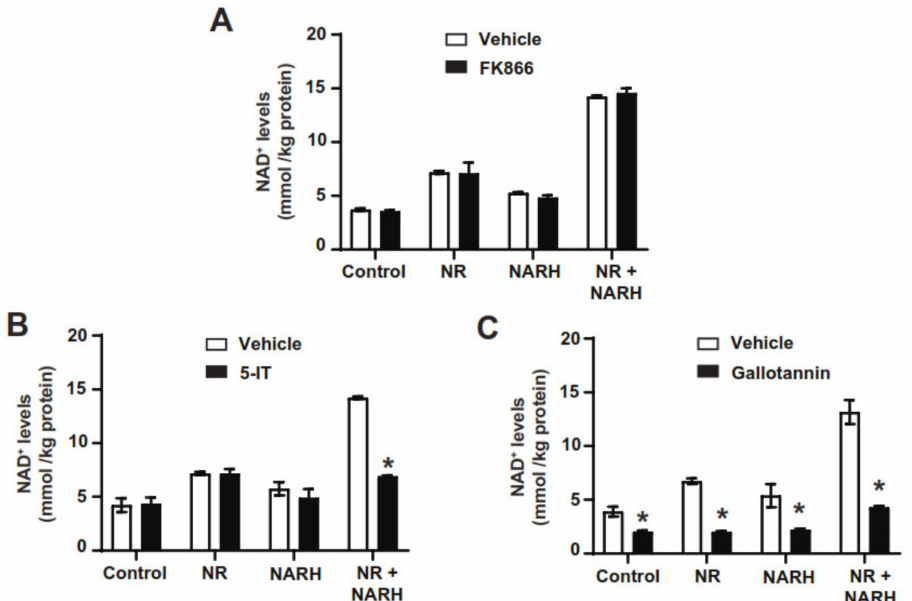
Figure 4. Unravelling the metabolic path by which NR + NARH increase NAD + levels. ( A ) AML12 were treated with DMSO (as vehicle) or FK866 (2 µ M) for 1 h and then treated with either PBS, NR (0.5 mM), NARH (0.5 mM) or both. Two hours later, acidic extracts were obtained to evaluate NAD + levels. ( B ) AML12 were treated with DMSO (as vehicle) or 5-IT (1 µ M;) for 1 h and then treated with either PBS, NR (0.5 mM), NARH (0.5 mM) or both. Two hours later, acidic extracts were obtained to evaluate NAD + levels. ( C ) AML12 were treated with DMSO (as vehicle) or gallotannin (100 µ M) for 1 h and then treated with either PBS, NR (0.5 mM), NARH (0.5 mM) or both. Two hours later, acidic extracts were obtained to evaluate NAD + levels. All data are presented as mean +/ − SEM of n = 3 independent experiments. * Indicates p < 0.05 vs. the respective vehicle treated